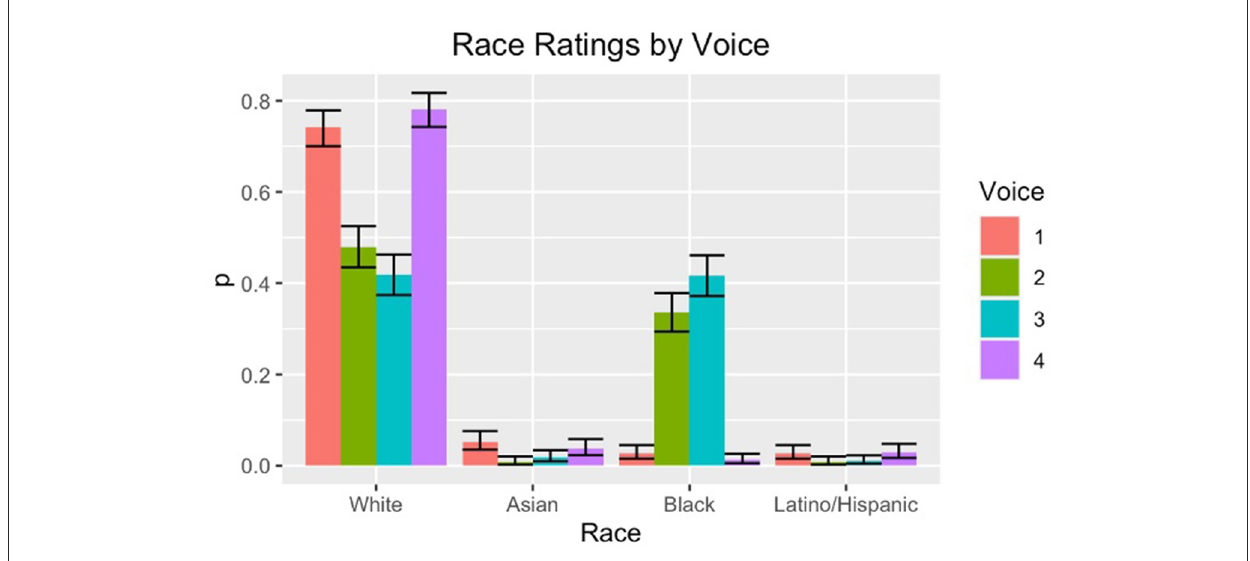
FIGURE3 Ratings for race by